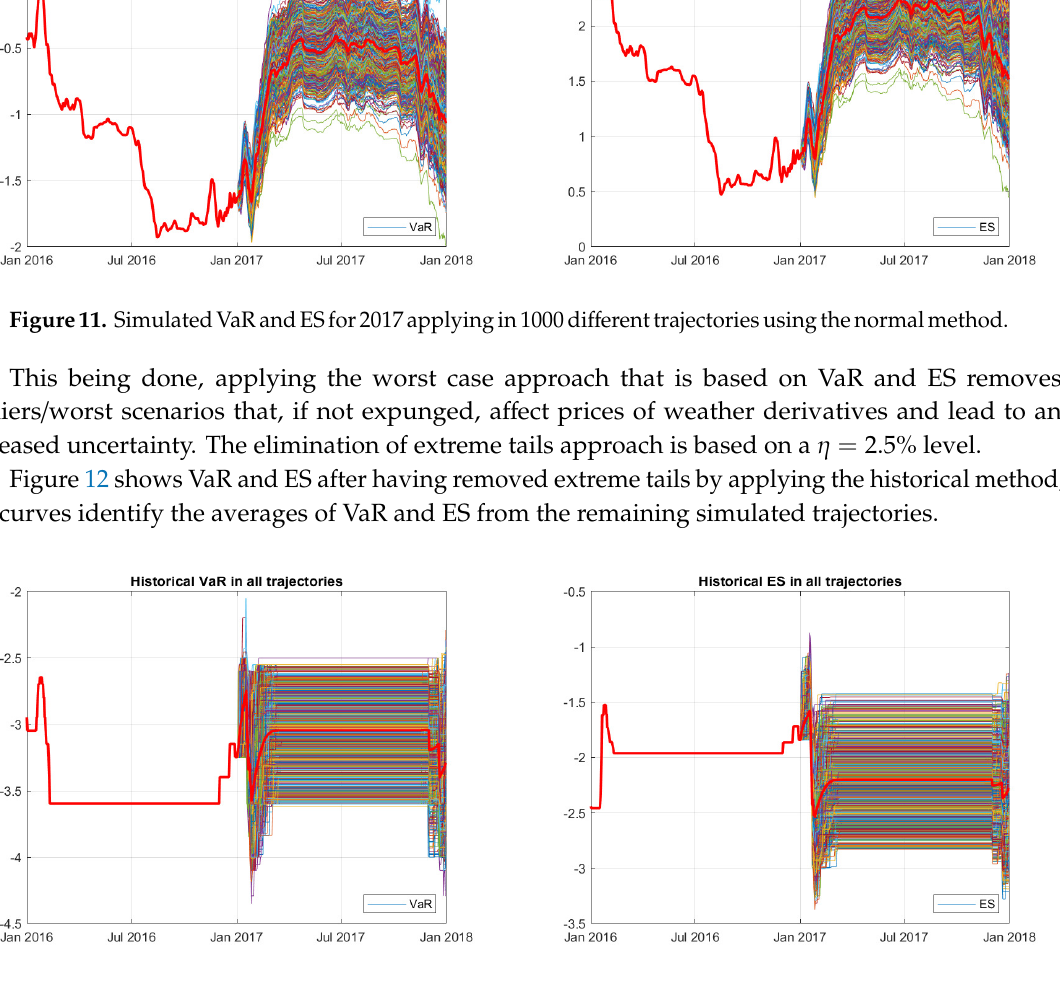
Figure 12. Simulated VaR and ES for 2017 upon removing extreme tails using historical method.